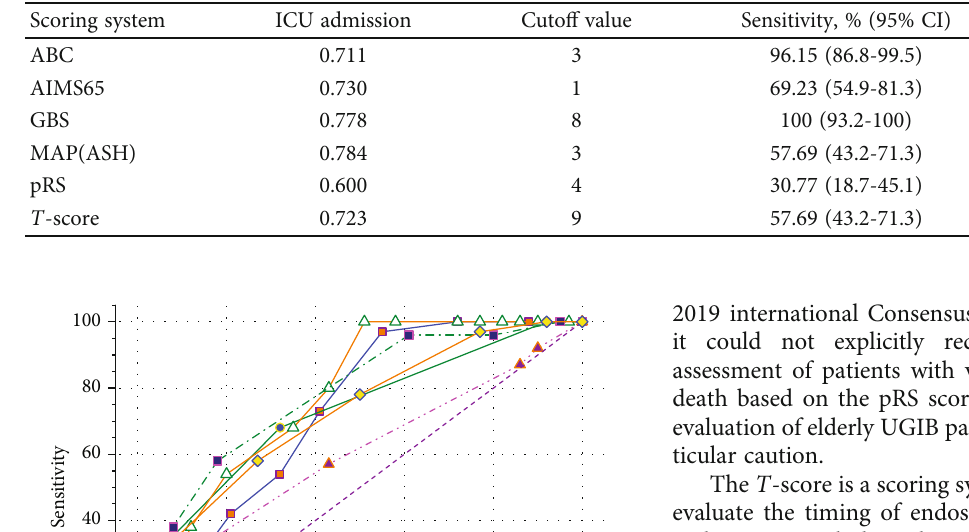
Table 7: Values of the six scoring systems in prediction of ICU